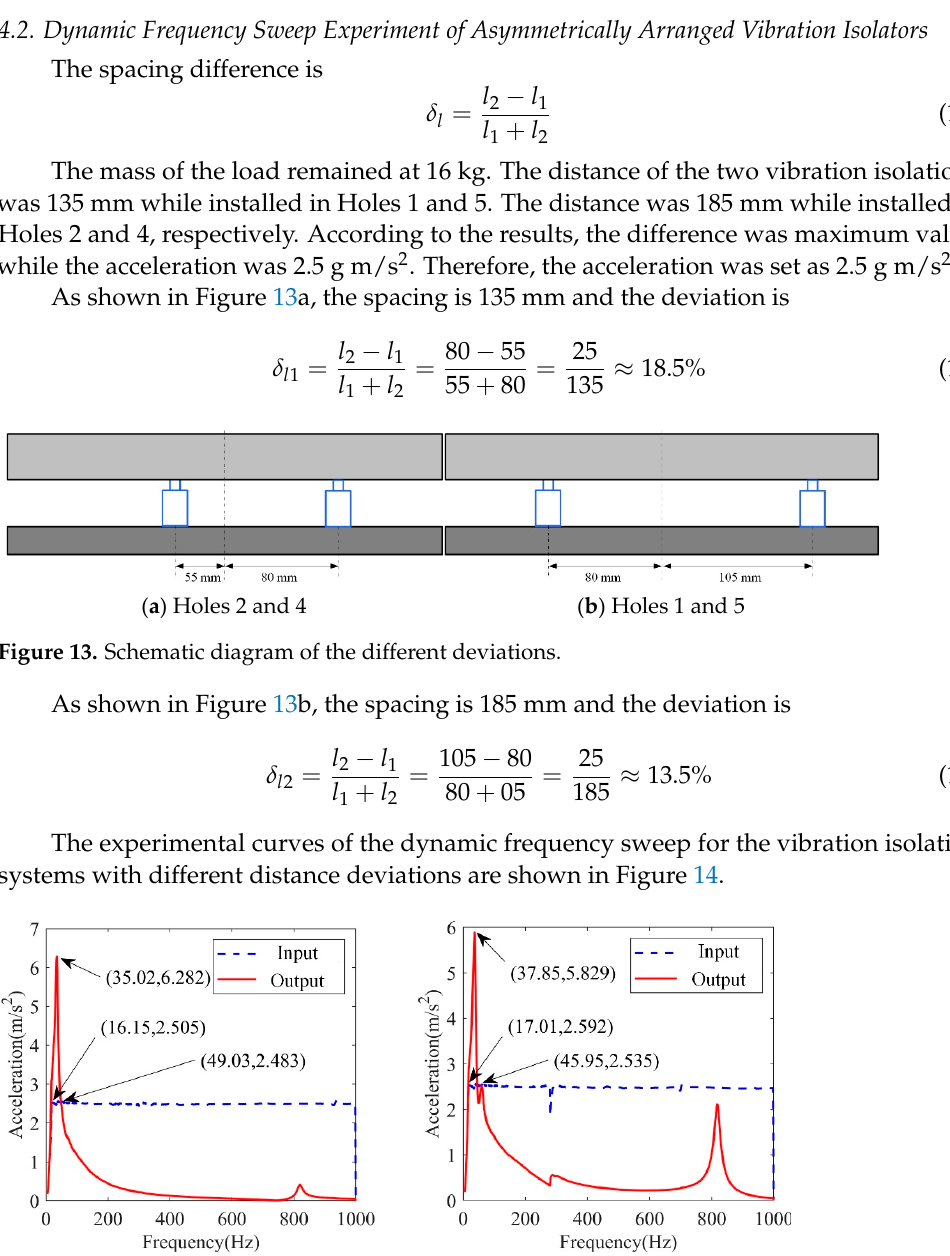
Figure 14. Experimental curves of the dynamic frequency sweep for vibration isolation systems with different distances.